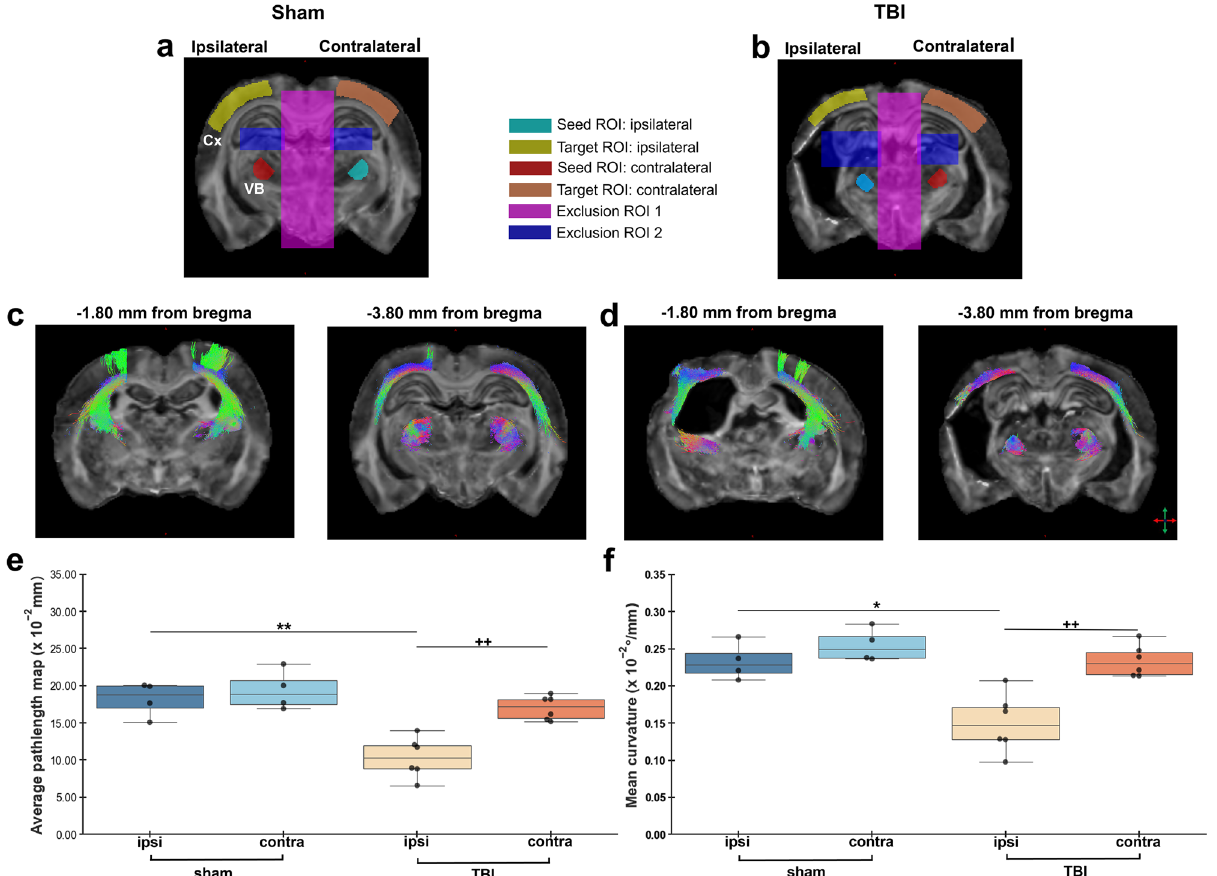
Figure 9. Targeted tractography. Probabilistic streamlines were generated using a combination of seed, target, and exclusion ROIs in sham-operated ( a ) and TBI ( b ) rats. 2D reconstruction of the thalamocortical pathway in a representative sham and TBI rat at − 1.80 mm and − 3.80 mm from bregma (c, d), colours indicate directionality: red, medio-lateral; green, dorso-ventral; blue, rostro-caudal. Track-weighted measures of average pathlength map and mean curvature computed from the generated tractograms (e, f). Results are shown as minimum, lower quartile, median, upper quartile and maximum, and paired t-test comparing ipsi- and contralateral sides within animals ( *q < 0.05, **q < 0.01) or unpaired t-test comparing the same hemisphere between sham-operated and TBI rats ( ++ q < 0.01) which are FDR corrected. Abbreviations: Cx, perilesional cortex; VB, ventrobasal